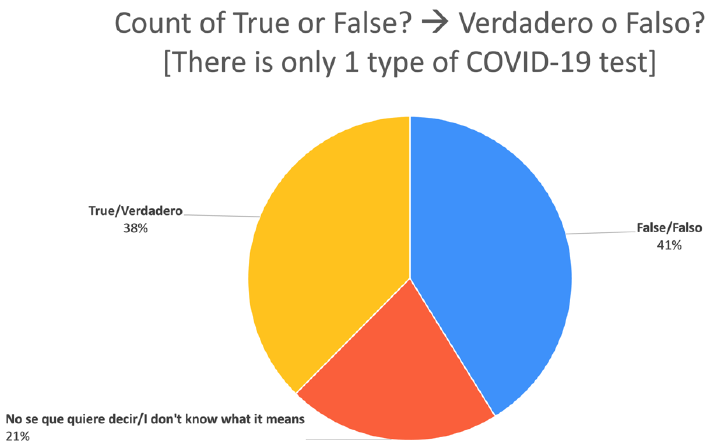
Figure 6. Pie chart representing data from classroom survey of social networks about understanding information about COVID-19 tests.